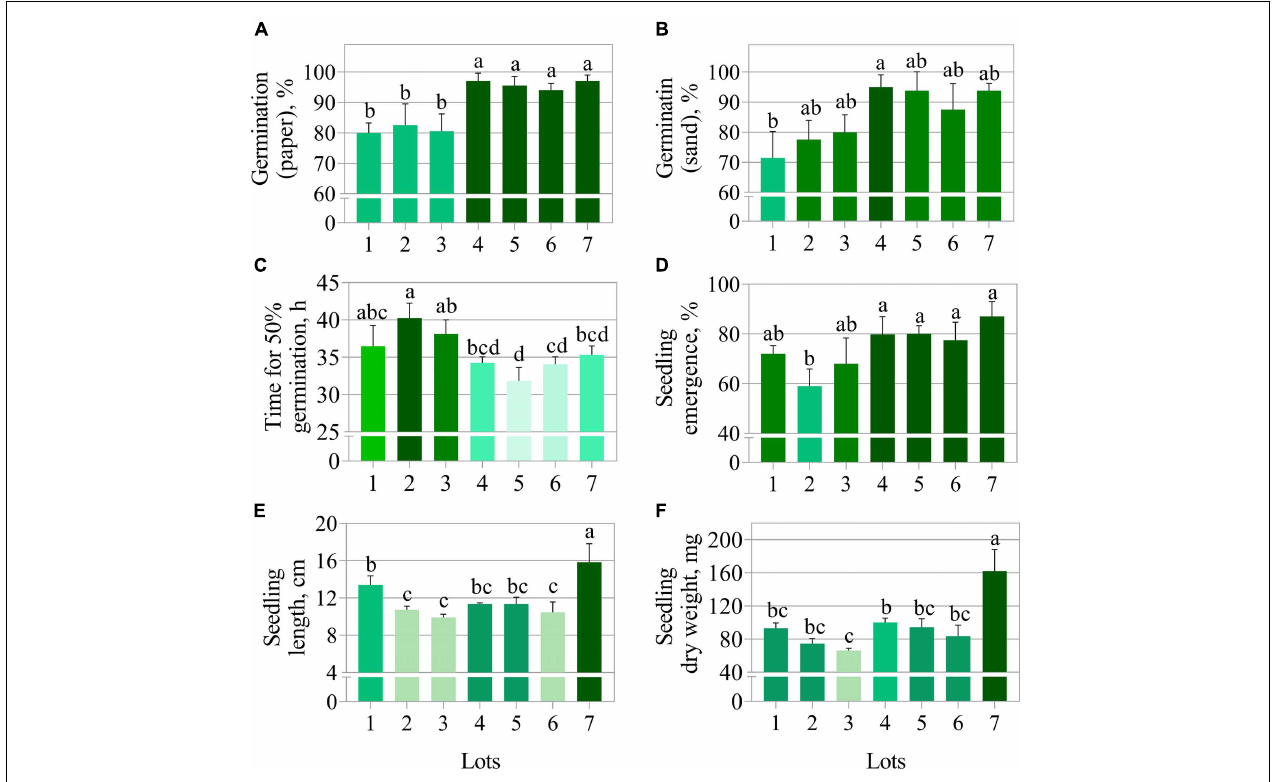
FIGURE 1 | Physiological quality of seven seedlots of peanut ( Arachis hypogaea L.; cv. IAC OL3) based on germination on paper (A) , germination on sand (B) , time for 50% germination (C) , seedling emergence (D) , seedling length (E) , and seedling dry weight (F) . Means ( ± standard deviation) with different letters indicate a significant difference ( p ≤